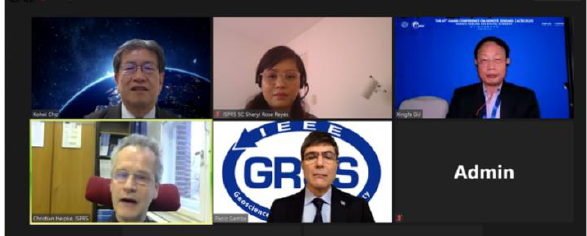
Figure 12. The panel discussion in ACRS 2020 on the roles of international academic societies in the